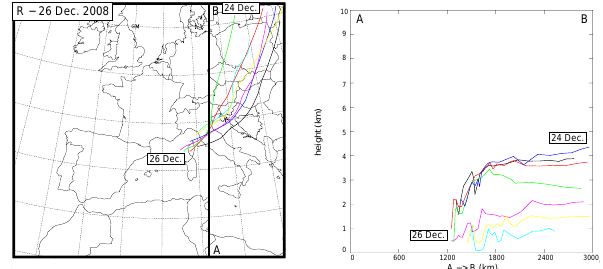
Fig. 16. Same as Fig. 13, but for the 26 December 2008 Roussillon